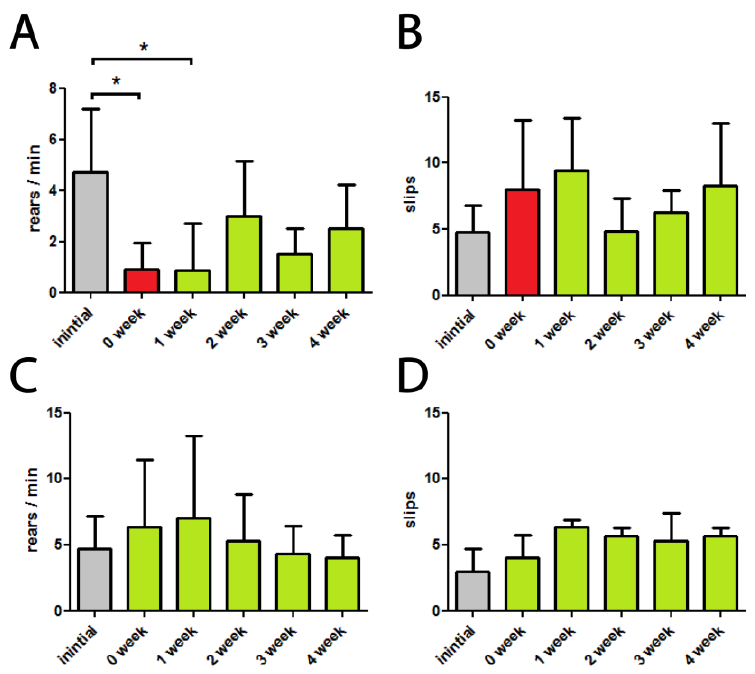
Figure 3. Effects of moderate physical activity treatment on rotenone-injected ( A , B ) and con- trol ( C , D ) mice. 0-week denotes the beginning of treatment, after 2 weeks of rotenone exposure. ( A – C ) The number of rears per minute in a cylinder test, * p < 0.05 ( B – D ) The number of paw slips (mistakes) in a beam walking